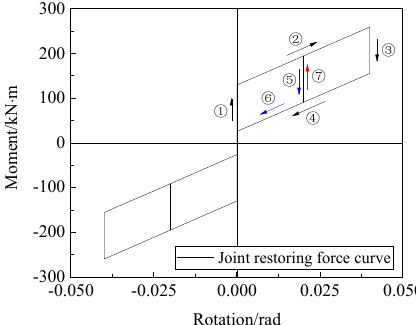
Figure 12. Theoretical joint restoring force model.